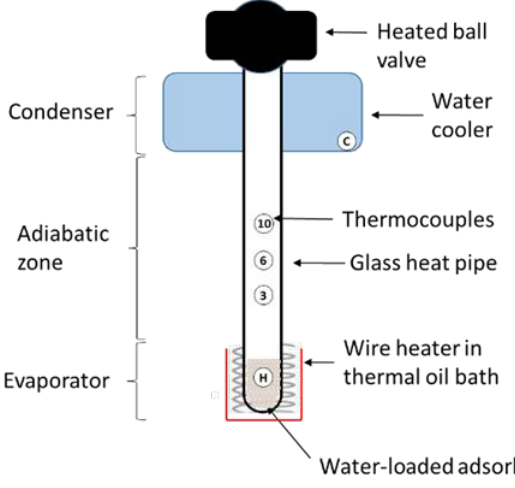
Figure 7. Heat pipe demonstrator. Positions of thermocouples are indicated by: H = thermocouple attached to heat pipe wire heater; C = thermocouple immersed in water in water cooler; 10, 6 and 3 = thermocouples attached in the adiabatic zone at 10, 6 and 3 cm above the surface of the thermal oil bath.